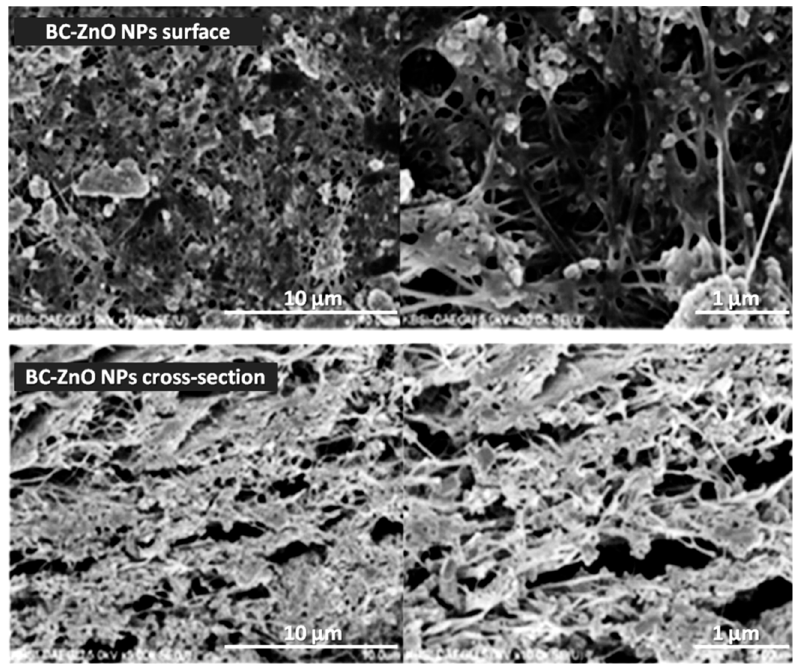
Figure 2. Field emission scanning electron microscopy (FE-SEM) images of surface and cross section of bacterial cellulose/zinc oxide (BC/ZnO) hybrids confirming ZnO nanoparticles (NPs) inclusion in the BC network [47].